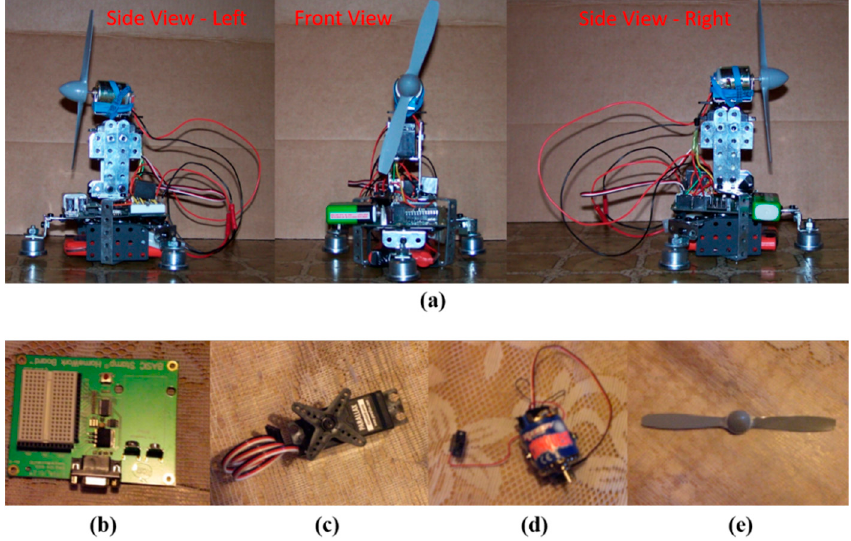
Figure 1. ( a ) Overview of the air-based propulsion to a land-based holonomic vehicle. Main components are: ( b ) Microcontroller board, ( c ) continuous-rotation servo motor, ( d ) direct current (DC) motor and ( e ) propeller.